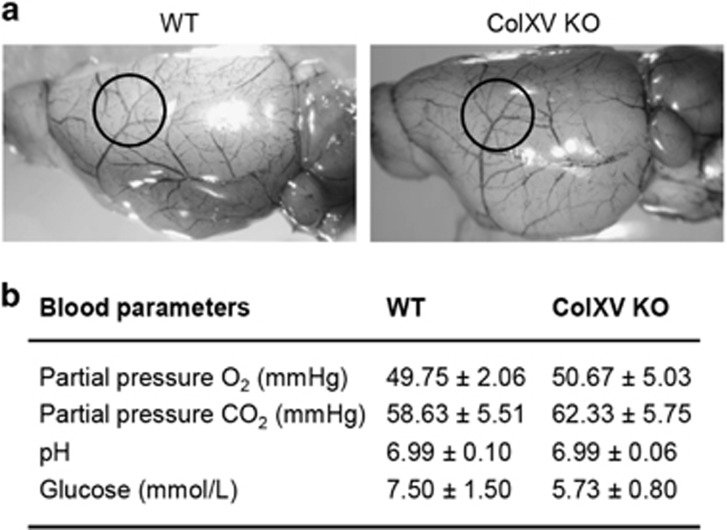
No differences of blood parameters and cerebral vasculatures between WT and ColXV KO mice. (a) Measurements of blood parameters in WT (N=4) and ColXV KO (N=3) mice 20 min after thromboembolic stroke. No significant difference in any of these parameters was noted between WT and ColXV KO mice. (b) Cerebral vasculature of WT and ColXV KO mice. Black circles indicate the middle cerebral artery bifurcation